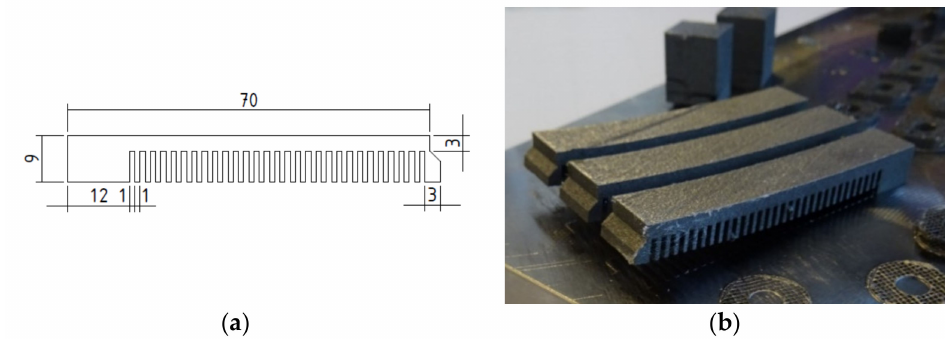
Figure 1. Design of cantilever beams for distortion measurement ( a ) and after cutting ( b ). Contour parameters were optimized to improve the surface roughness. After selecting the possible parameters via the optical evaluation (Olympus SZX10 stereomicroscope (Olympus, Tokyo, Japan)) of single line tests, the roughness values of the vertical and 45 ◦ angled samples were measured using a mechanical Mitutoyo SJ-210 portable roughness measurement device (Mitutoyo, Kawasaki, Japan) for optimization. Table 1 shows the parameters used for the line tests. Three layers of cubes using only contour parameters were printed. All samples were produced on an EOS EOSINT M280 machine (EOS, Munich,